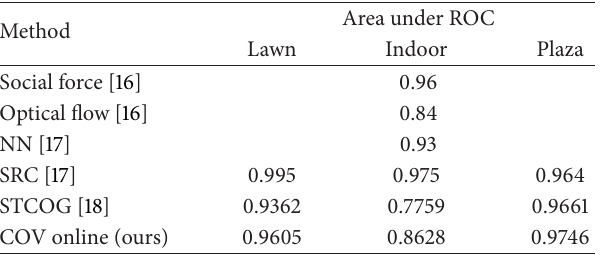
Table 3: The comparison of our proposed method with the state- of-the-art methods for the abnormal event detection in the UMN